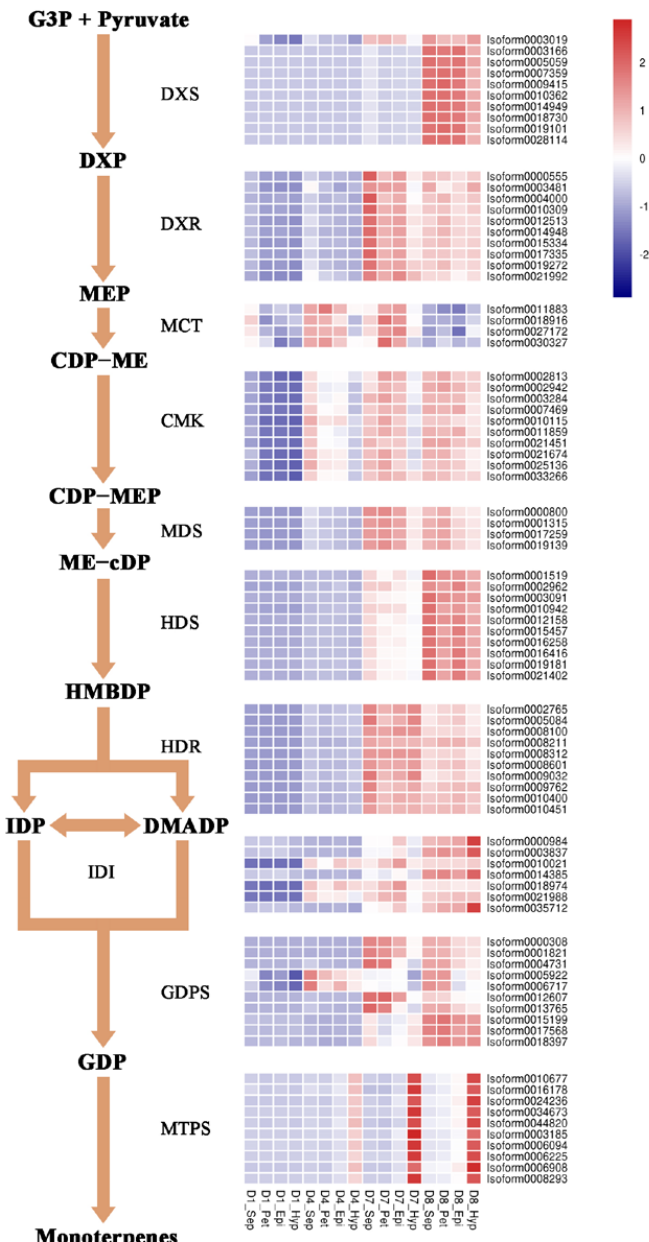
Figure 5. The spatiotemporal expression profiles of MEP pathway structural genes. According to a previous study, KOVA flower development is classified into eight stages, including D1 (i.e., bub length <2 cm), D4 (i.e., bub length 4–5 cm), D7 (i.e., two days after flowering), and D8 (i.e., ten days after flowering) [25]. A heatmap analysis of the expression levels of MEP pathway structural genes in the sepals, petals, epichile, and hypochile from D1 (developmental stage 1) to D8 is displayed. The transcriptome data were provided by a previous study [25] and reanalyzed in this study. If there are more than ten homologous transcripts, only ten homologous transcripts are displayed; the expressions of all MEP pathway genes are displayed in the additional file (Supplementary Figures S1 and S2). The data are the mean ± SD from three biological replicates. Abbreviations for compounds or enzymes not described in this article are as follows: G3P, glyceraldehyde-3-phosphate; DXP, 1- deoxy- D -xylulose 5-phosphate; MEP, methylerythritol phosphate; CDP-ME, 4-diphosphocytidyl-2-C- methylerythritol; CDP-MEP, 4-diphosphocytidyl-2-C-methyl- D -erythritol 2-phosphate; ME-cDP, 2-C- methyl- D -erythritol 2,4-cyclodiphosphate; HMBDP, 4-hydroxy-3-methyl-but-2-enyl pyrophosphate; IDP, isopentenyl diphosphate; DMADP, dimethylallyl diphosphate; GDP, geranyl